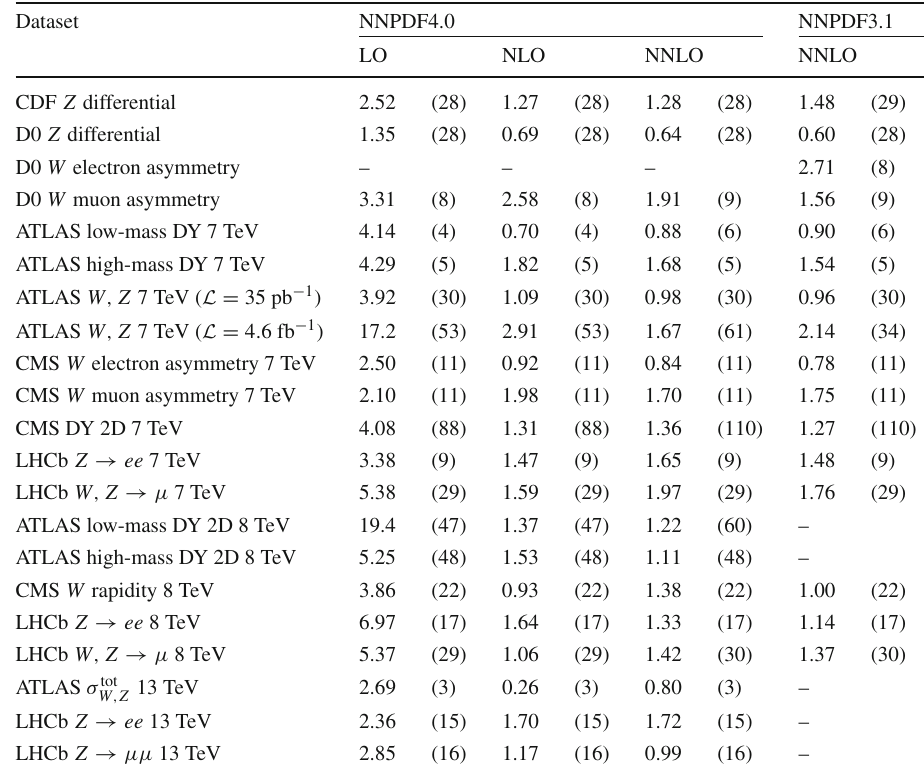
Table 21 Same as Table 19 for inclusive gauge boson production